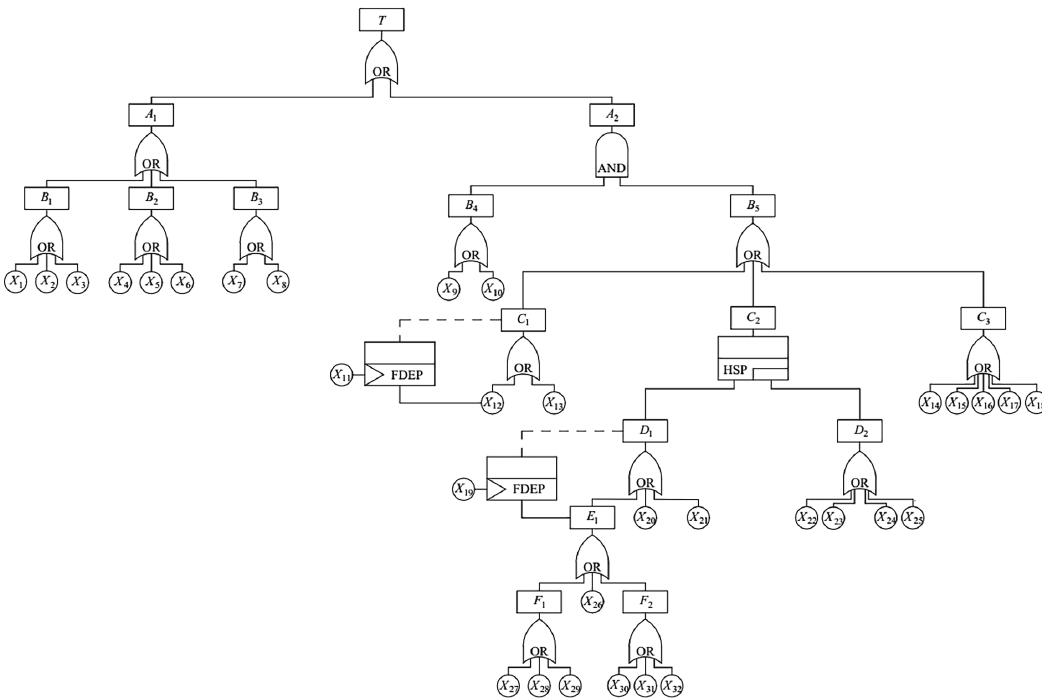
Figure 10. DFT structure diagram for water leakage of